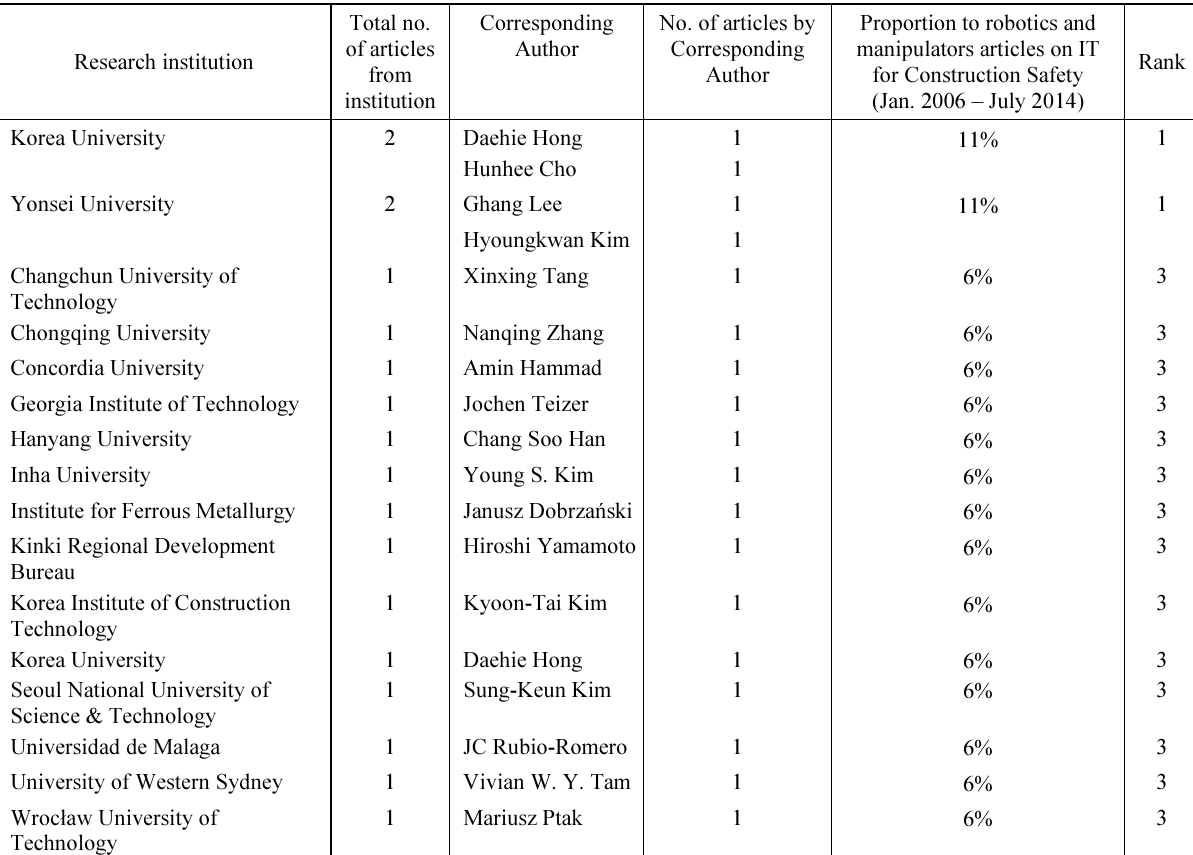
Table 6. Major institutions and corresponding authors on robotics and manipulators for construction safety management